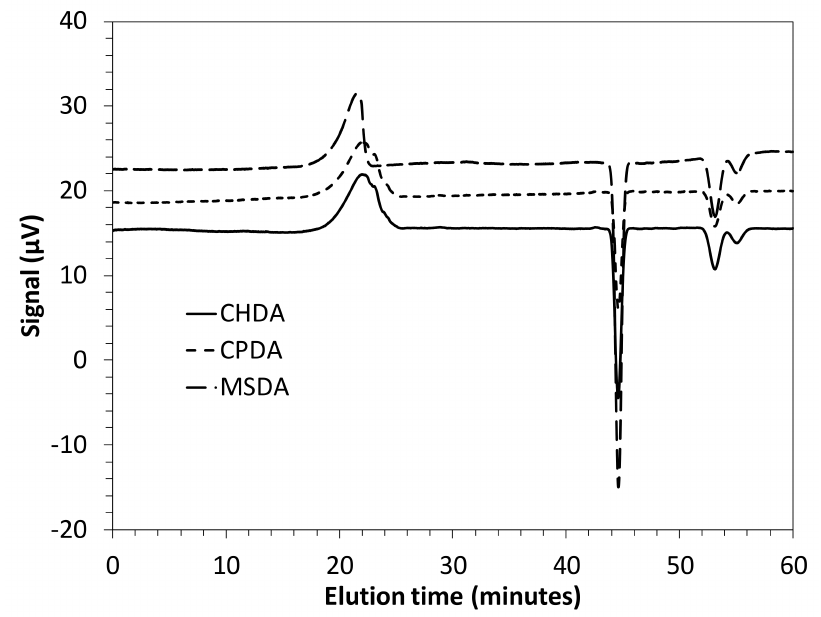
Figure 2. Size exclusion chromatography (SEC) eluographs of the synthesized biopolyimide